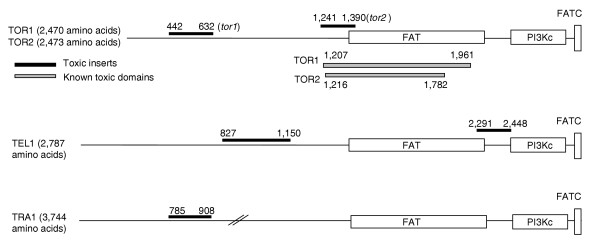
Positions of selected toxic fragments relative to the structure of genes of the PI kinase family. Names of the selected genes and protein lengths (in amino acids) are indicated. Coordinates of the toxic fragments selected in this work and of known toxic domains (see text) are also given. Conserved domains in the proteins have been positioned using the NCBI CD-Search program [64] (see Materials and methods). Domain abbreviations: FAT (pfam 00259) is named after FRAP, ATM and TRRAP, which are human homologs of yeast TOR, TEL1 and TRA1, respectively; PI3Kc (smart00146) is the PI kinase catalytic domain; FATC (pfam02260.11) is named after FRAP, ATM, TRRAP carboxy-terminal region. Complete COG5032 TEL1 (2,105 residues) spans the carboxy-terminal regions of the four proteins. The drawing is not to scale.